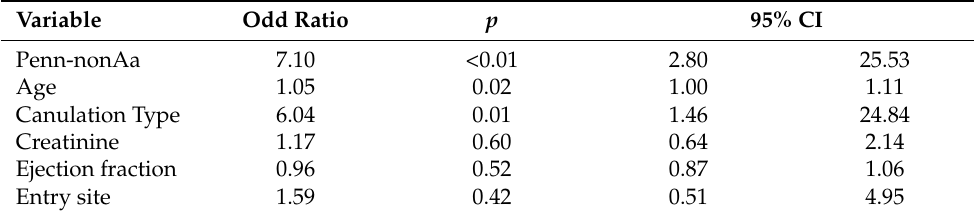
Table 3. Multivariate risk analysis for early death.